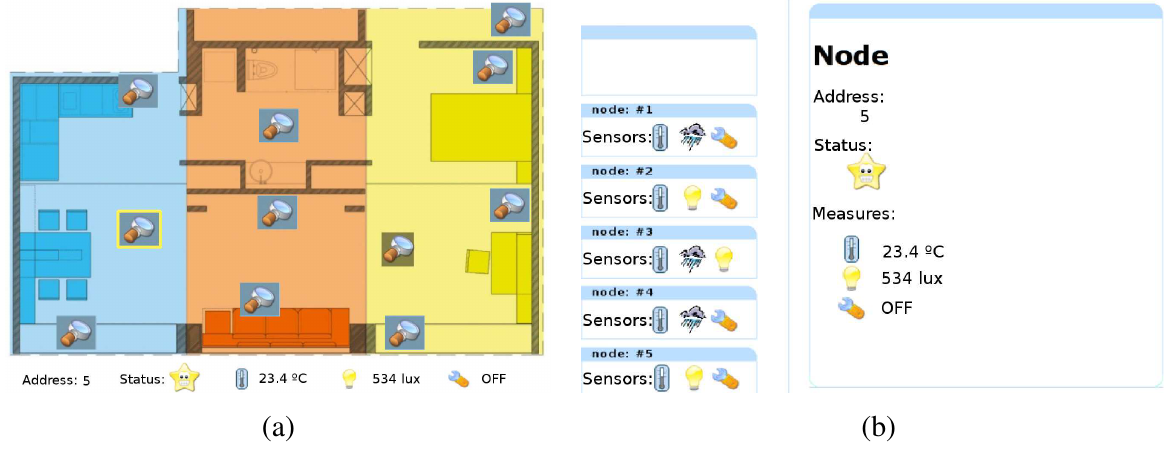
Figure 9. Data monitoring interface. (a) A map-like approach. (b) A node list